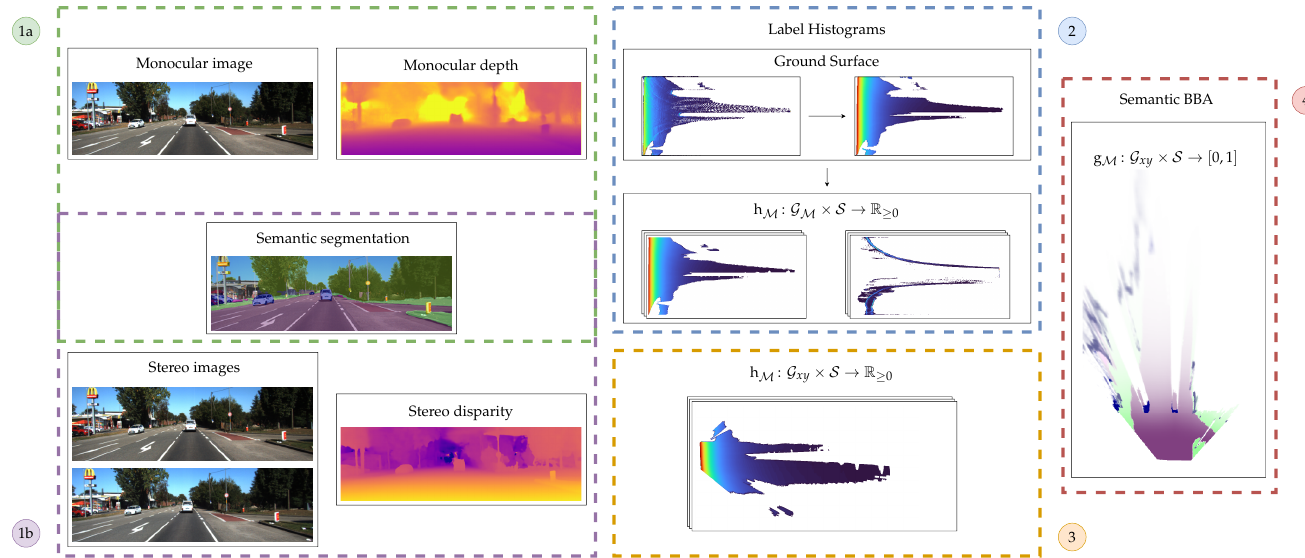
Figure 1. Overview of the described grid mapping framework. On the front end, both monocular images are processed to obtain depth maps ( 1a ) or stereo images are used to estimate a disparity map ( 1b ). Both of them are accompanied by a pixelwise semantic segmentation image. The images are used as input for a label histogram calculation in a setup-dependant grid in the second step ( 2 ). This label histogram is transformed into a cartesian grid ( 3 ) and finally transformed into a semantic evidential grid map ( 4